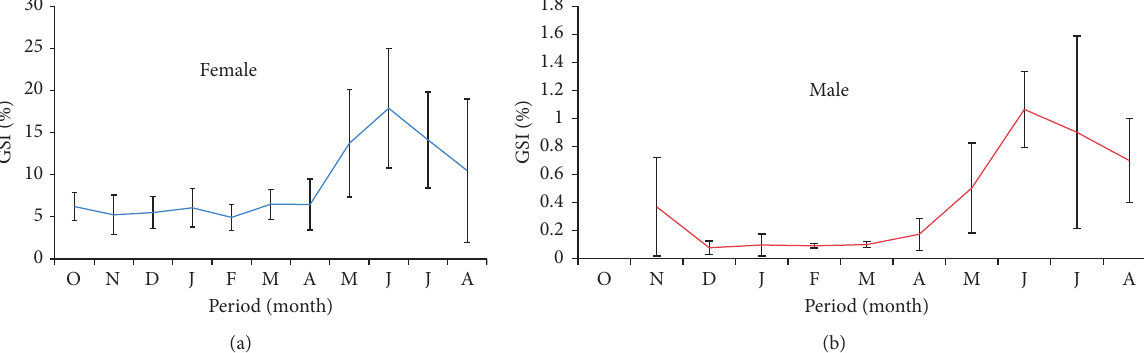
Figure 4: Monthly evolution of GSI by sex of C. nigrodigitatus between October 2015 and August 2016 in the Nkam River: (a) female, (b)